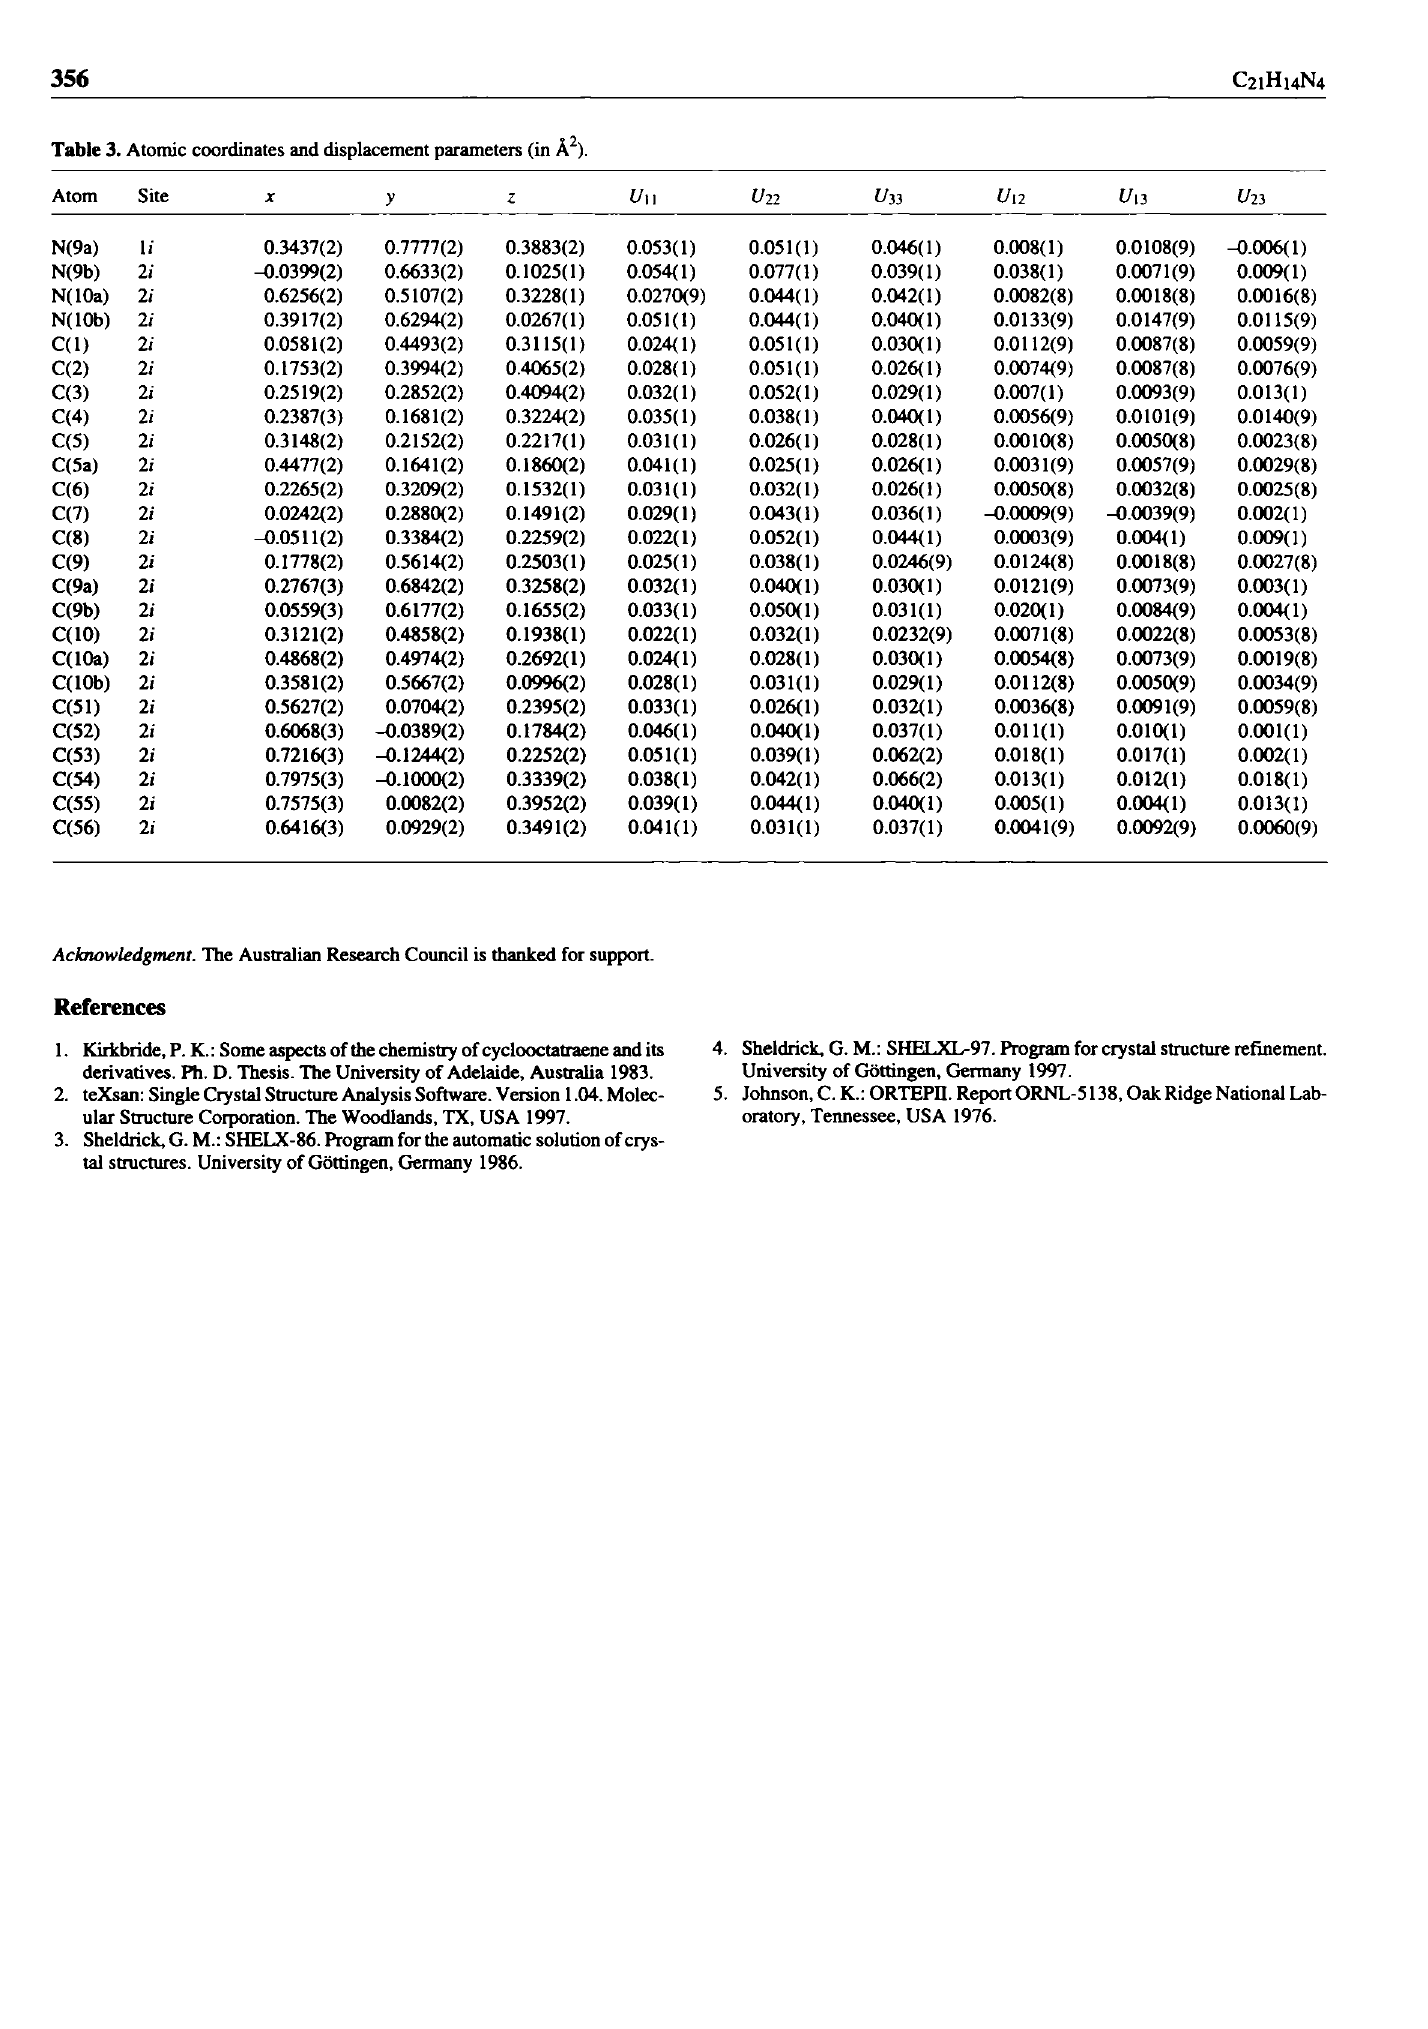
Table 3. Atomic coordinates and displacement parameters (in À 2